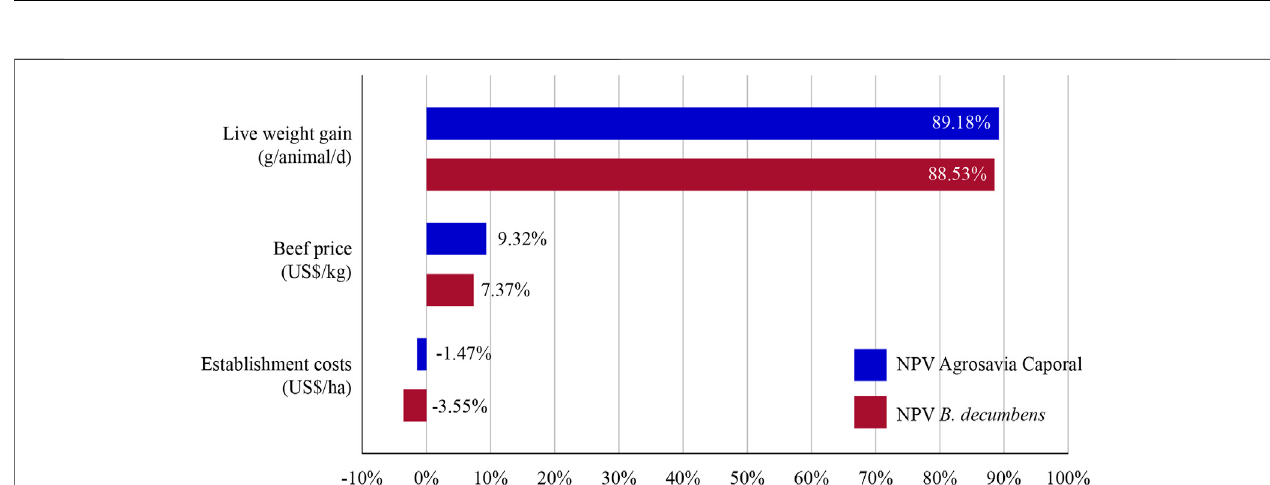
FIGURE 3 | Probability and accumulative density distributions of the NPV.